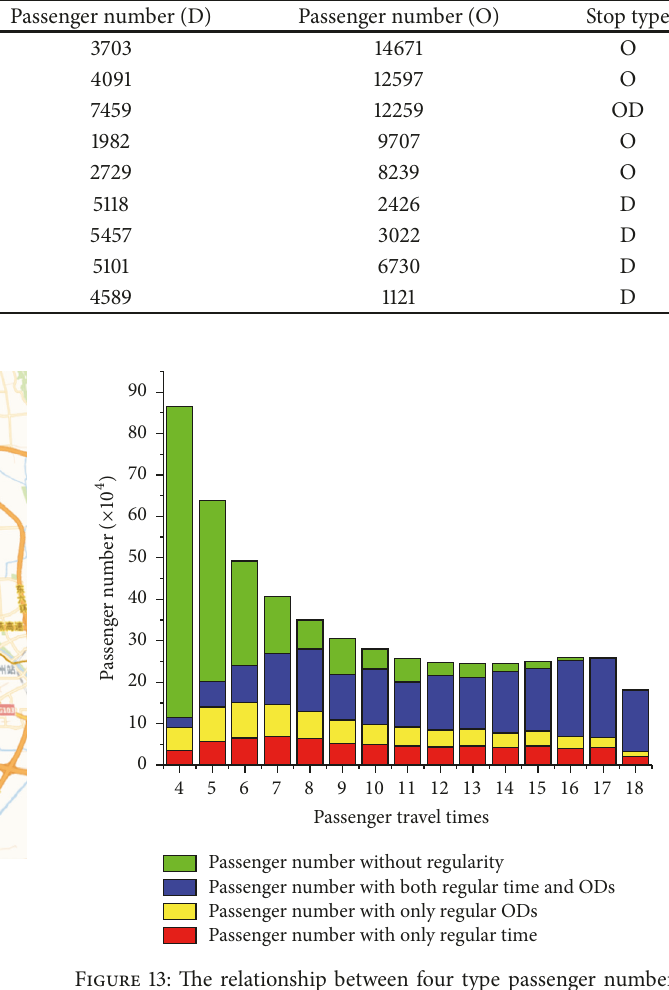
Figure 12: The top five origin stops and destination stops with the most passengers in the evening.